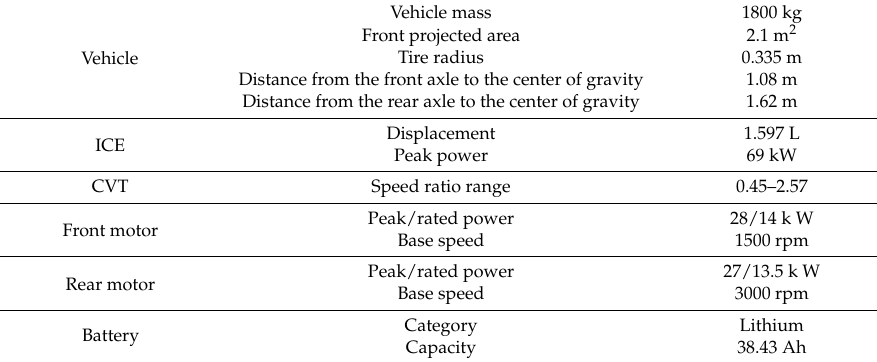
Figure 1. Configuration of the hybrid electric vehicle. Table 1. Vehicle data and main components parameters